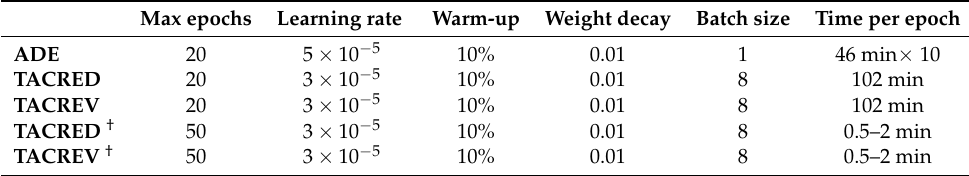
Table 2. Hyperparameters for the different datasets. (Setting:few-shot = †